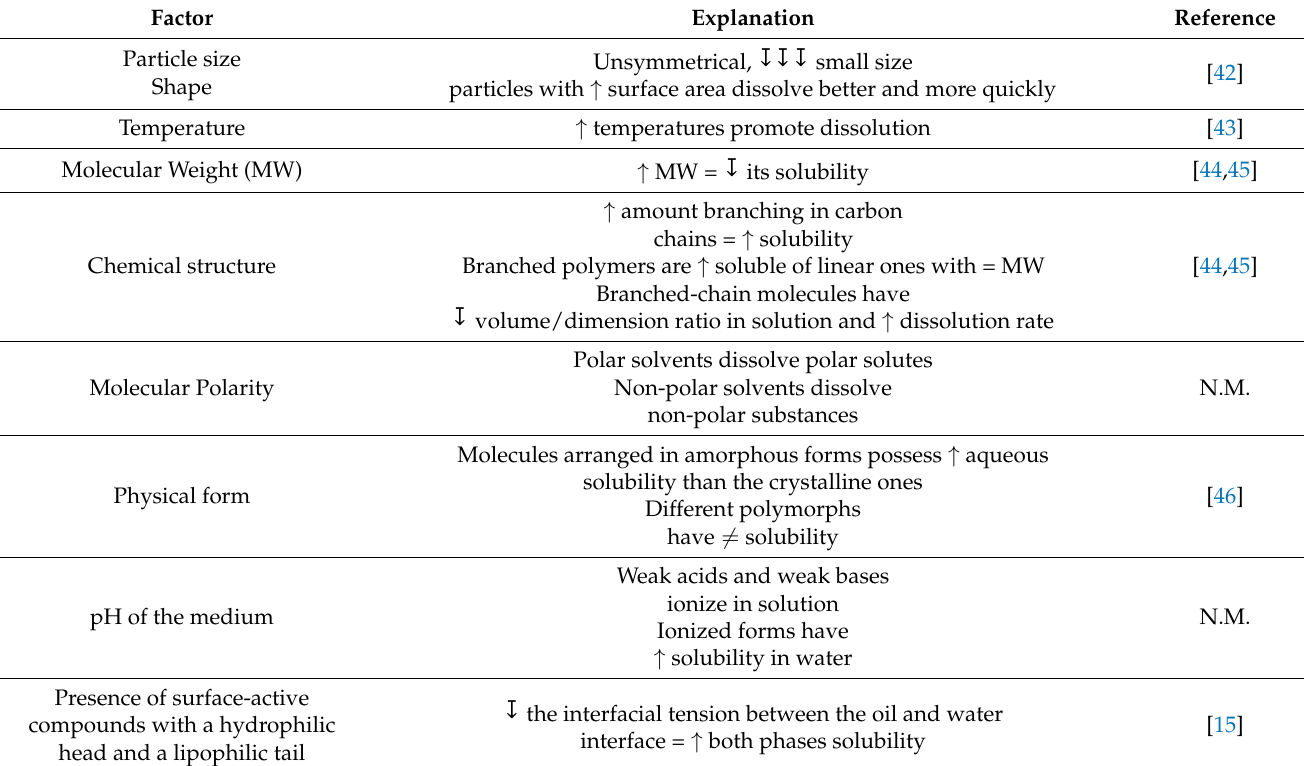
Table 2. Main factors which influence the solubility of a substance.